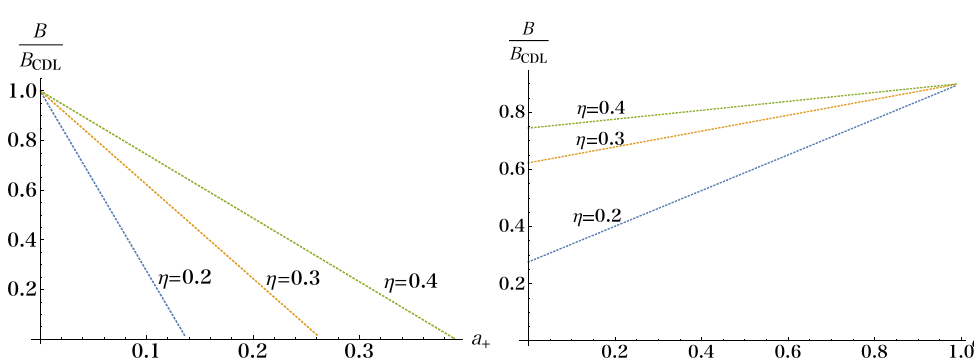
Figure 3 . In the left panel, we show the bounce action for the bubble seeded by the cloud of strings without a remnant for the parameter choice (cid:17) = 0 : 2, 0 : 3 and 0 : 4. In the right panel, the bounce action for (cid:12)xed a + = 0 : 1 as a function of (cid:14) = a (cid:0) =a + with (cid:17) = 0 : 2, 0 : 3 and 0 :